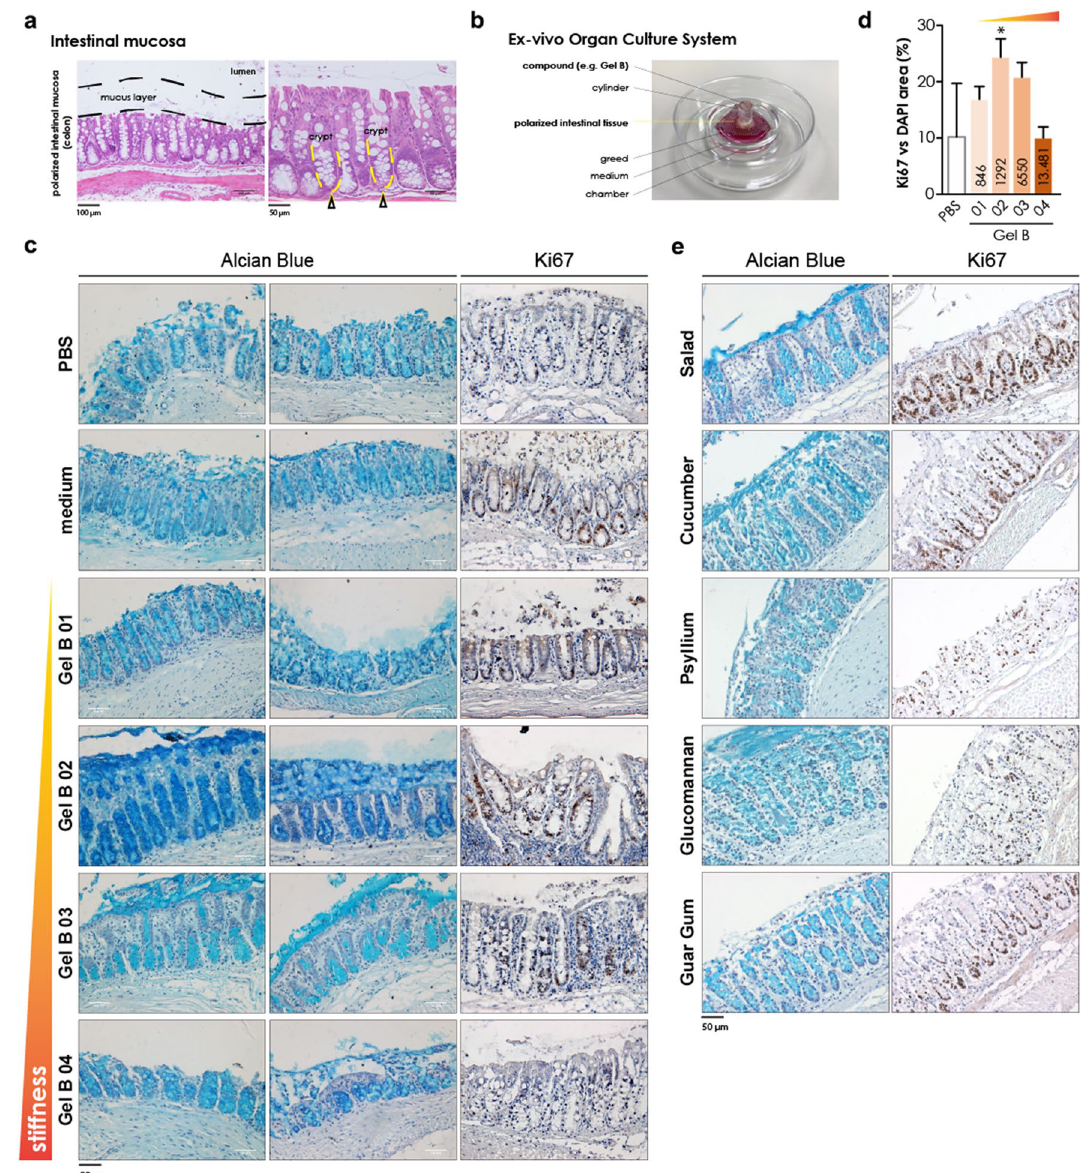
mucosa (strongly stained by the eosin, pink; nuclei are stained with hematoxylin, light blue): some crypts are highlighted in yellow, while the yellow arrows indicate the base of the crypts, containing the highest number of proliferating cells in the healthy tissue. ( b ) Ex vivo Organ Culture System. ( c ; e ) Alcian Blue staining and Ki67 staining of colonic tissue EVOC specimens. The mucus is stained in blue; Ki67 positive (proliferating) nuclei are in brown; total nuclei in all the images are counterstained with hematoxylin. ( d ) Quantification of the Ki67 staining (expressed as Ki67-positive area over total nuclei area) reported in panel ( c ); values in the bars refer to the gel elasticity (G ′ ), while *indicates significant difference ( p < 0.05) with respect to the